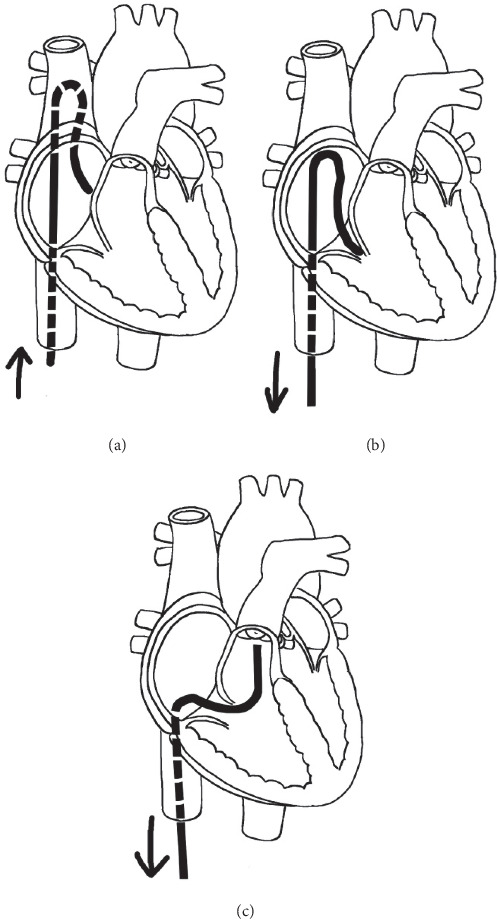
(a) The Simmons catheter is advanced directly into the superior vena cava with its original appearance. (b) The catheter is withdrawn slowly and sent over the TV with an adjusted angle. (c) The catheter will flip into the RVOT automatically.